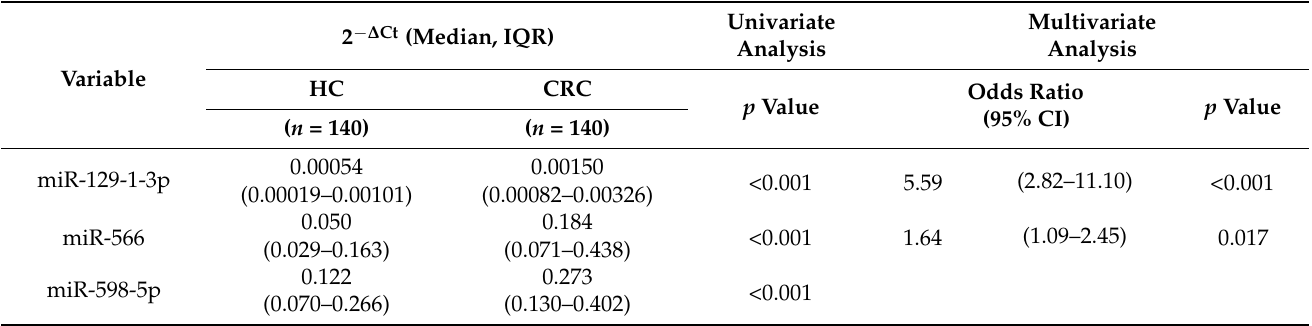
Table 2. Urinary miRNA expression in the training